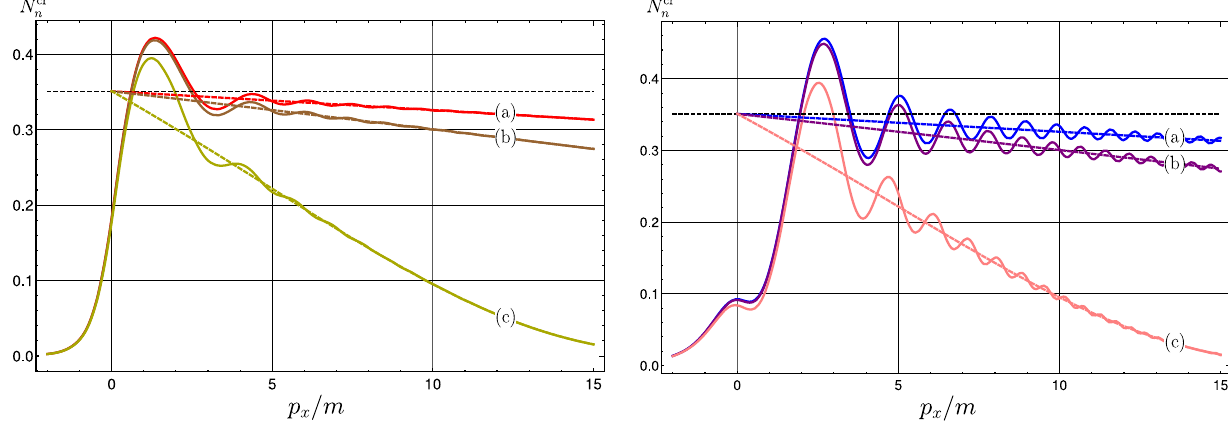
Fig. 4 Differential mean number N cr n of Fermions (left panel) and Bosons (right panel) created from the vacuum by an inverse square decreasing electric field (41). The exact differential mean N cr n given by the absolute squared value of Eq. (44) are represented by solid lines